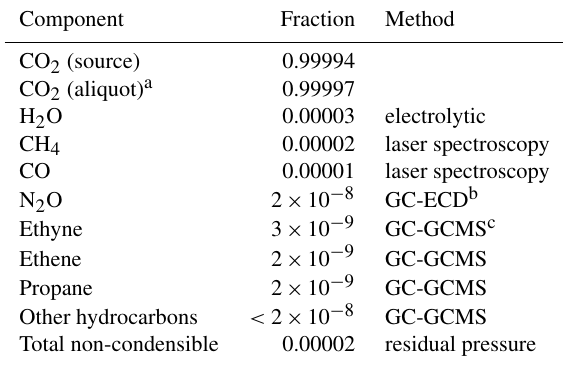
Table 2. CO 2 purity assessment.